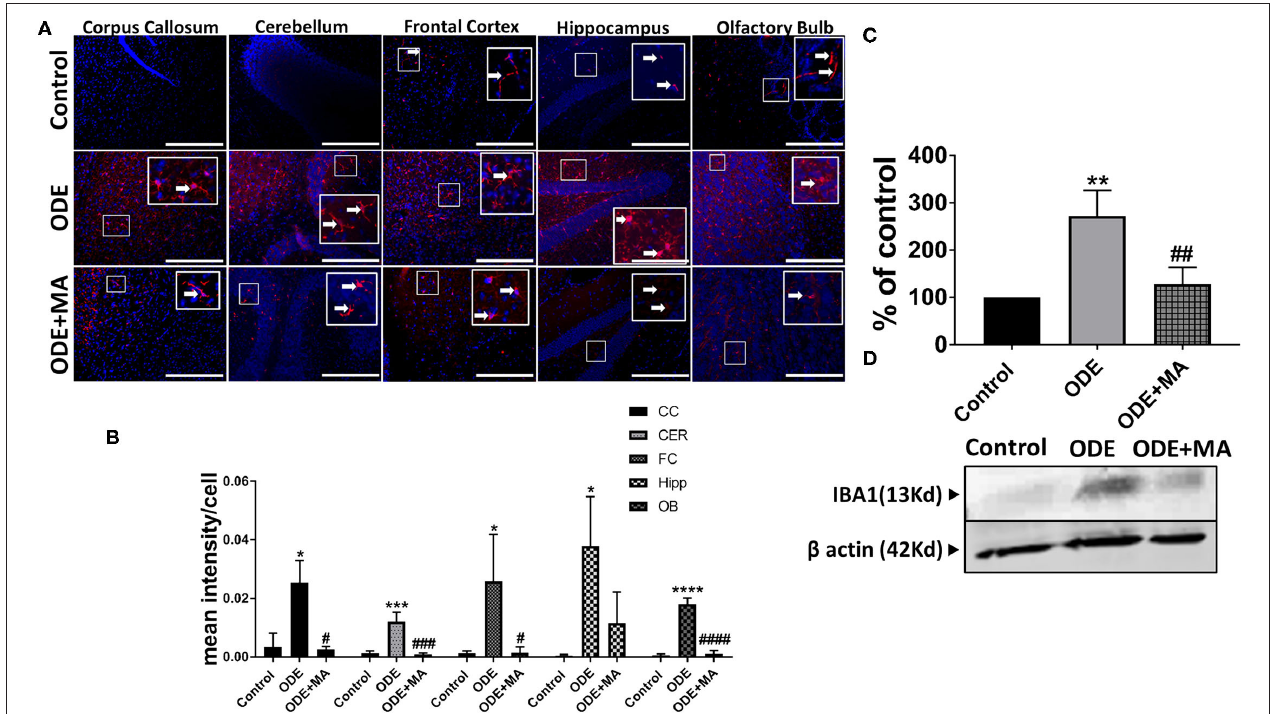
FIGURE 4 | ODE induces IBA1 expression in various regions of mice brain. Paraffin-embedded sections from perfused mice brain were stained with anti-IBA1 (white arrow, Cy3, red) antibody, and nuclei were identified with DAPI (blue). (A) IBA1 expression in IHC was quantified by a blinded investigator. Compared to control, ODE-exposed mice showed higher amounts of IBA1 staining in the corpus callosum, cerebellum, frontal cortex, hippocampus, and olfactory bulb of the brain. MA (C11) treatment significantly reduced IBA1 expression in the corpus callosum, cerebellum frontal cortex, and olfactory bulb regions of brain (B) . Whole cell lysate from freshly dissected mice brain were processed for western blot analysis. IBA1 and β -actin antibodies (house-keeping protein) detected 13 and 42 kD bands, respectively. Densitometry of normalized bands showed that, compared to controls, ODE exposure increased the IBA1 protein level in mice brain, and that MA treatment significantly reduced IBA1 protein level (C,D) ( n = 5, *exposure effect, # MA treatment effect, p < 0.05, micrometer bar = 50 µ